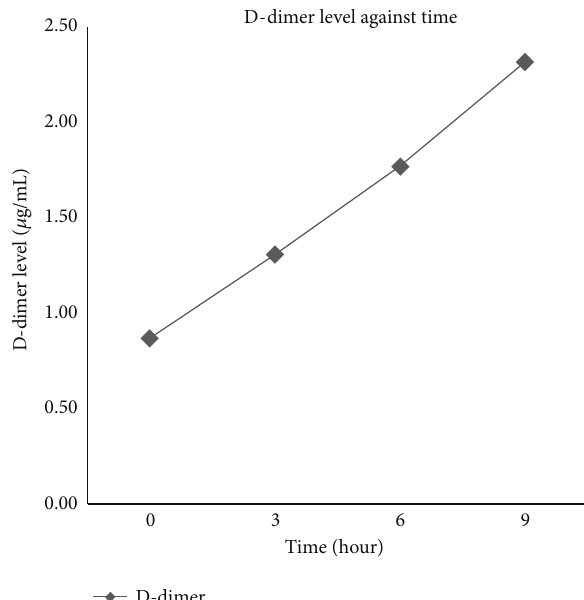
Figure 1: Line graph of D-dimer level against time of whole blood clot lysis in plasma.